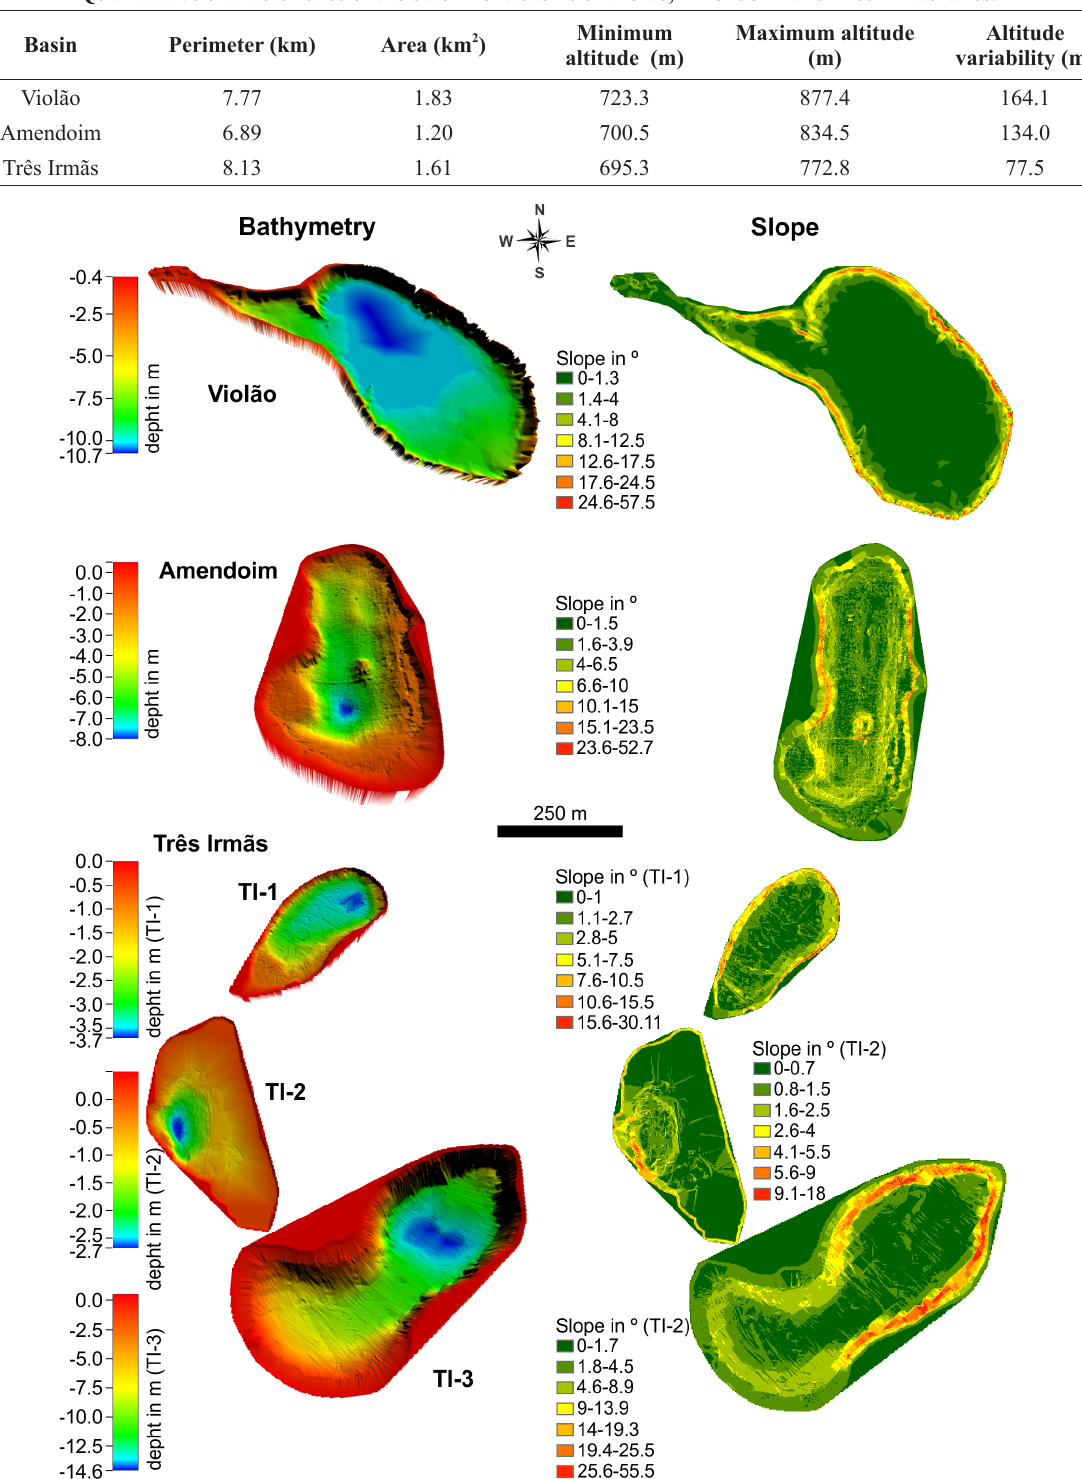
Quantitative characteristics of the catchment basins of Violão, Amendoim and Três Irmãs